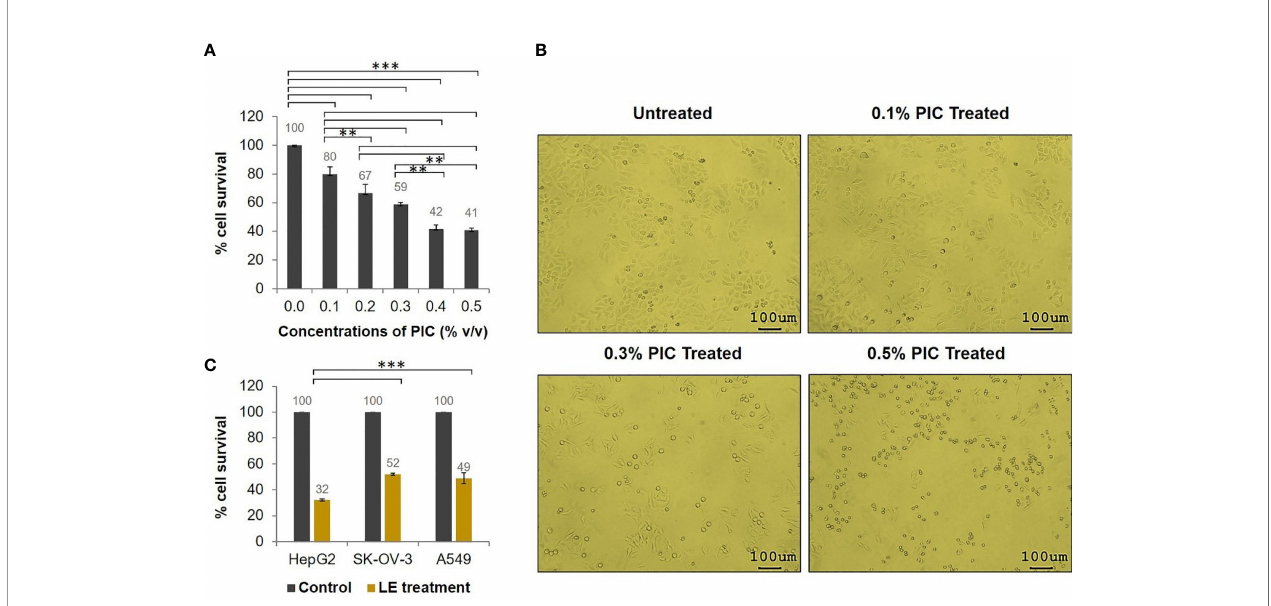
FIGURE 1 | Antitumor activity of the T. spiralis infective larval extracts (LE). HepG2, SK-OV-3, and A549 cells (5 × 10 3 cells) in individual wells of a 96-well culture plate were treated with 70 µgmL -1 of T. spiralis LE for 24 h. (A) Percentage cell survival of HepG2 cells at 24 h posttreatment with different concentrations of PIC. (B) Morphological alteration and proliferation of HepG2 cells at 24 h after treatment with different concentrations of PIC visualized at 100× microscopic magni fi cation. (C) Percentage cell survivals of HepG2, SK-OV-3, and A549 cells at 24 h posttreatment with 70 µgmL -1 of LE compared with the control (cells treated with medium supplemented with 0.05% PIC). The results are shown as the mean ± standard deviation (SD) of three independent experiments. ∗∗ P < 0.01; ∗∗∗ P <